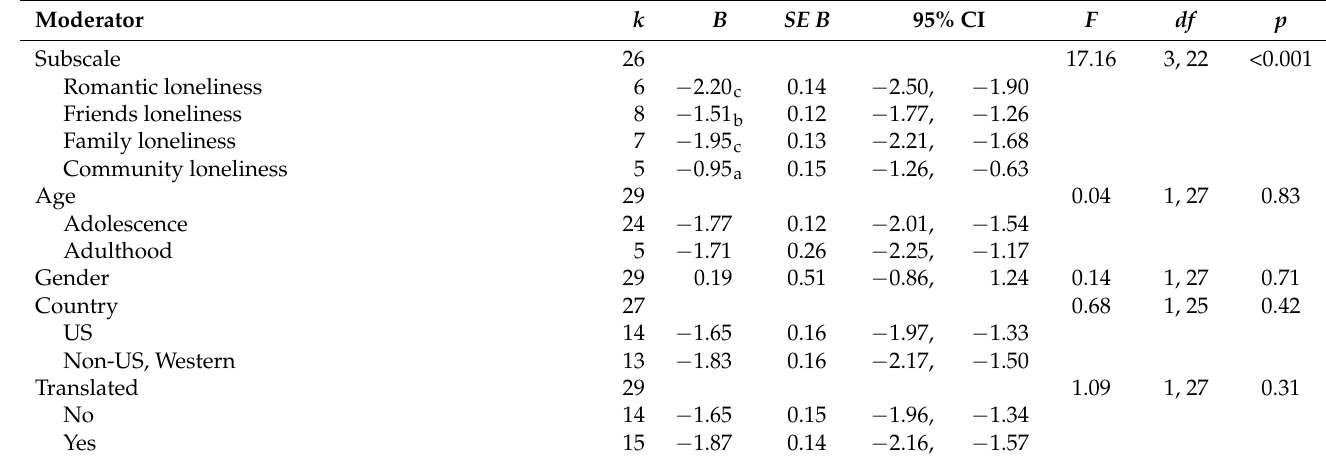
Table A4. Separate Regression Analyses for the Moderators Predicting Reliability Scores of the Differential Loneliness Scale (DLS).